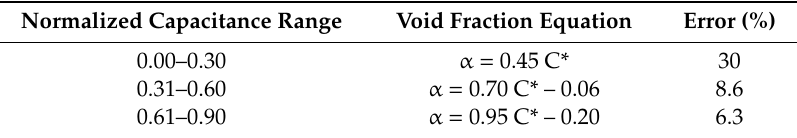
Figure 17. Void fraction versus the normalized capacitance for three uniform bubble distributions. Table 1. Extracted fitted data from the simulation